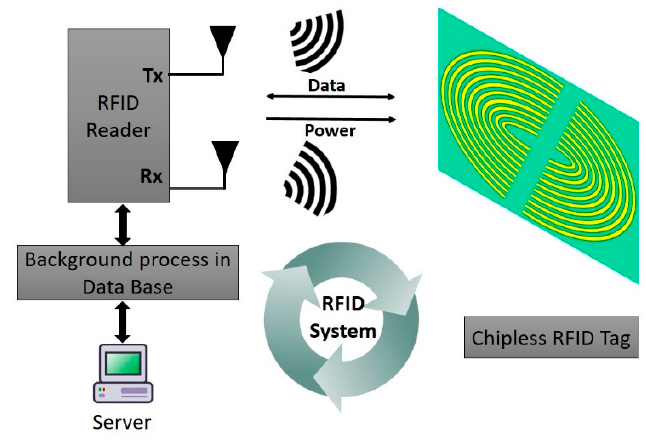
Figure 7. RFID system components.